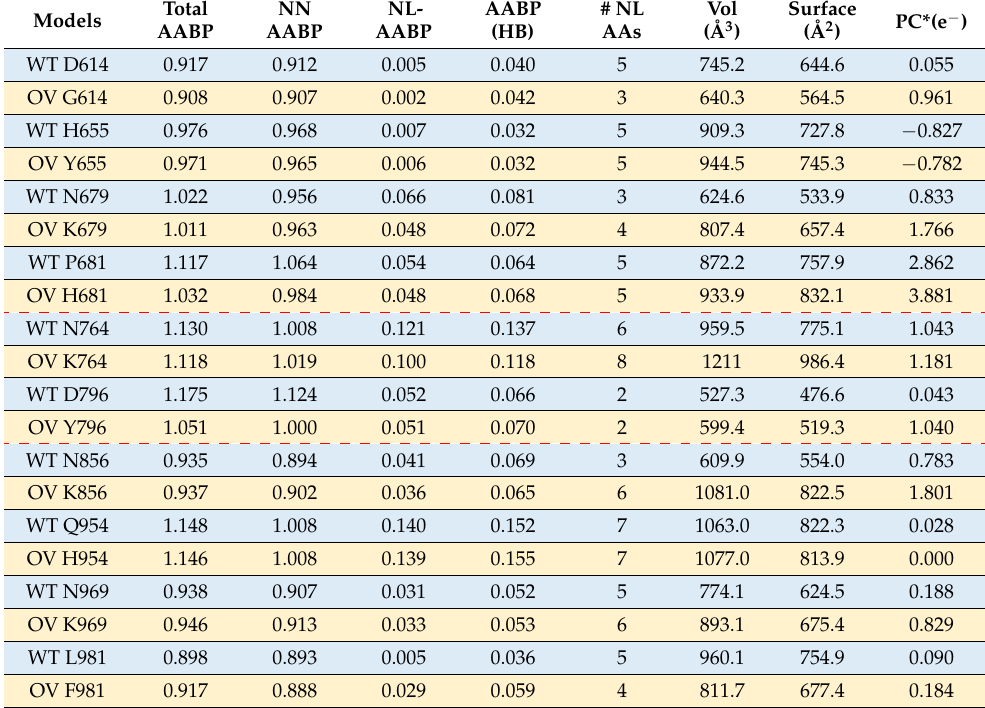
Table 1. AABP results due to the mutation of the Omicron variant close to the cleavage site, six SD2-FP regions, and four HR1-CH regions. Red dash lines are locations of S1/S2 and S2 (cid:48) cleavages separating the 10 mutations. The first six mutations are labeled as group A, the second two mutations as group B, and the last four mutations as group C to facilitate the association of their relative positions with respect to the cleavage sites. AABP in units of electrons (e − ). The light blue and tan color rows represent WT and OV